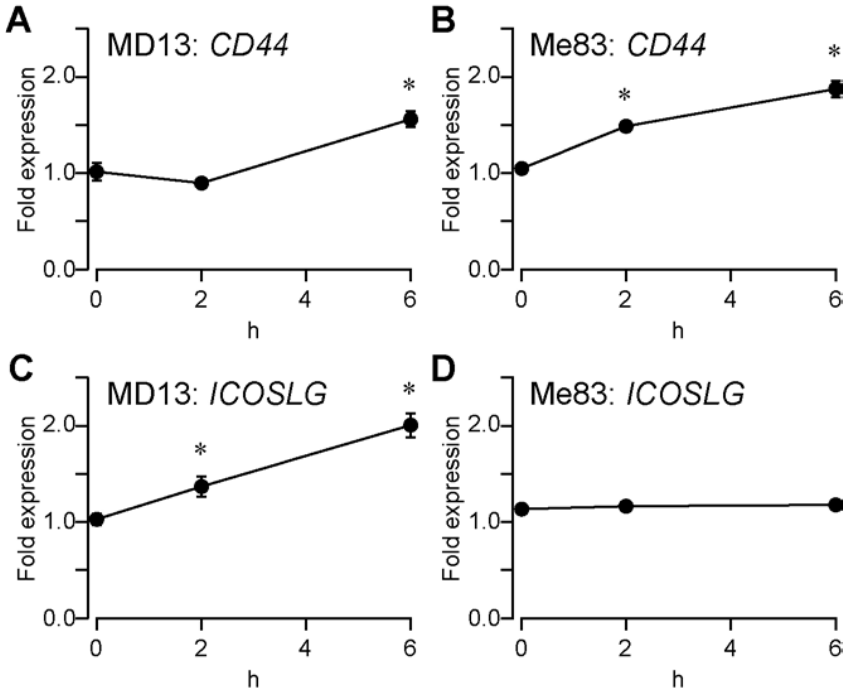
Figure 5. qRT-PCR analysis. GSCs were treated with 2% sevoflurane for 2 or 6 h. Then, the mRNA levels of CD44 , ICOSLG , PROM1 , OLIG2 , and human 18S rRNA were assessed by q RT-PCR. Fold expression of CD44 in ( A ) MD13 and ( B ) Me83 cells. Fold expression of ICOSLG in ( C ) MD13 and ( D ) Me83 cells. Their expression levels were normalized with human 18S rRNA. The expressions of PROM1 and OLIG2 were not detected. Data are presented as mean ± SD ( n = 3). Differences between groups were evaluated using one-way analysis of variance. * p < 0.05, as compared with the value at 0 h.